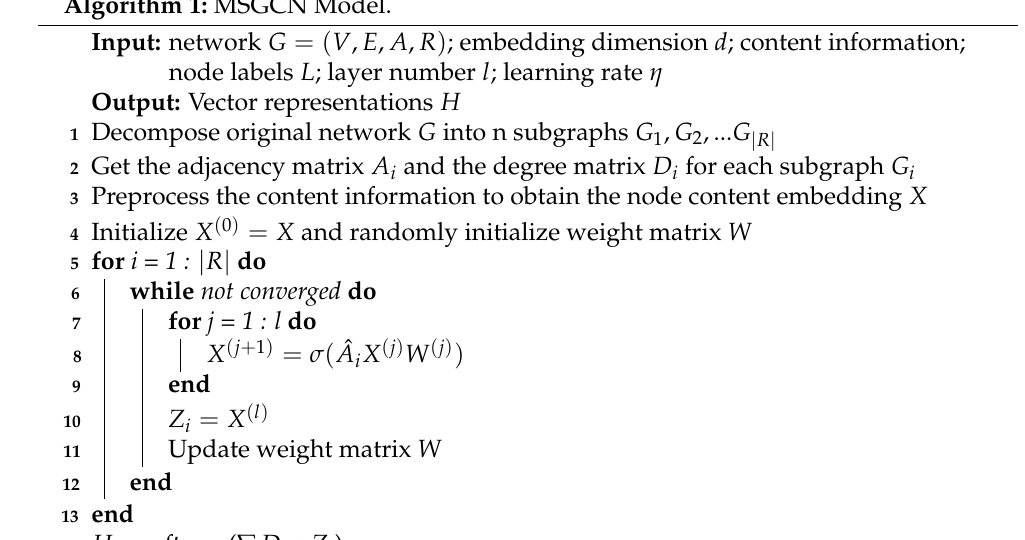
Algorithm 1: MSGCN